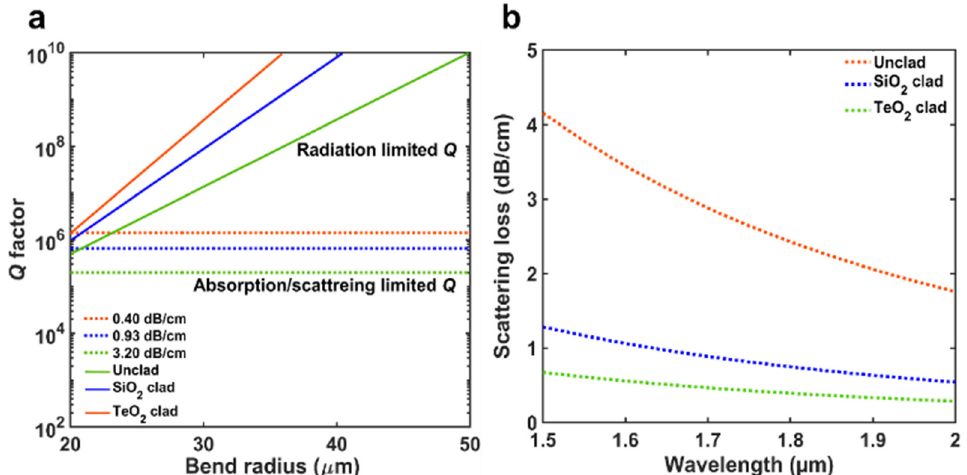
Figure 4. ( a ) Calculated internal Q factor of uncoated-, SiO 2 -coated, and TeO 2 -coated silicon resonator waveguides versus bend radius. ( b ) Calculated scattering loss as a function of wavelength for microring resonators with air, SiO 2 , and TeO 2 claddings based on the 3D Payne–Lacey model.